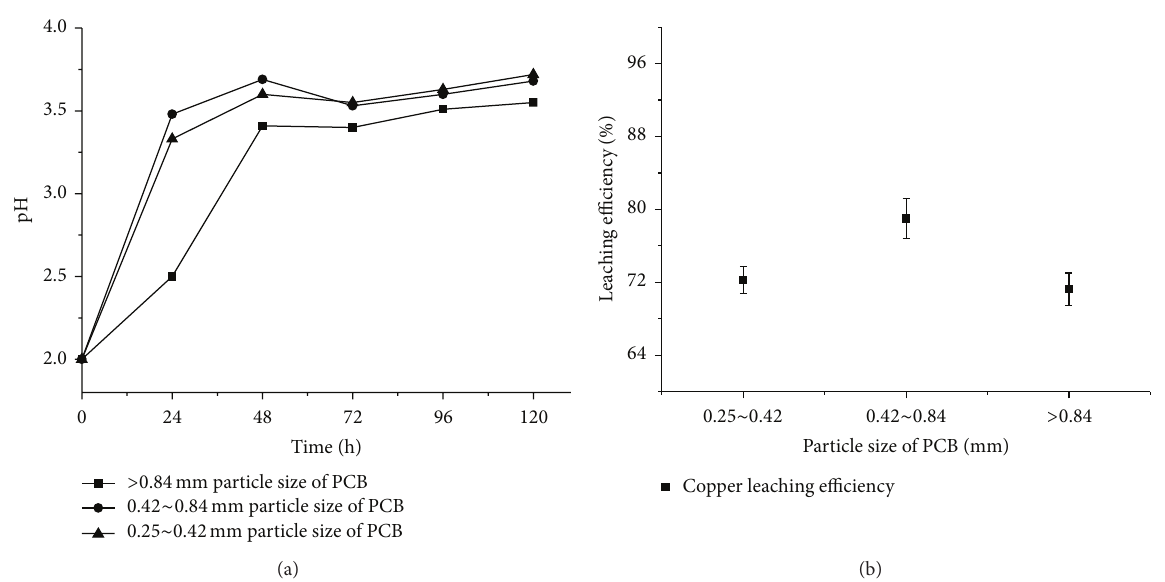
Figure 2: Different particle sizes of PCB and medium pH changed with time (a) and 5 days leaching and copper leaching efficiency (b).